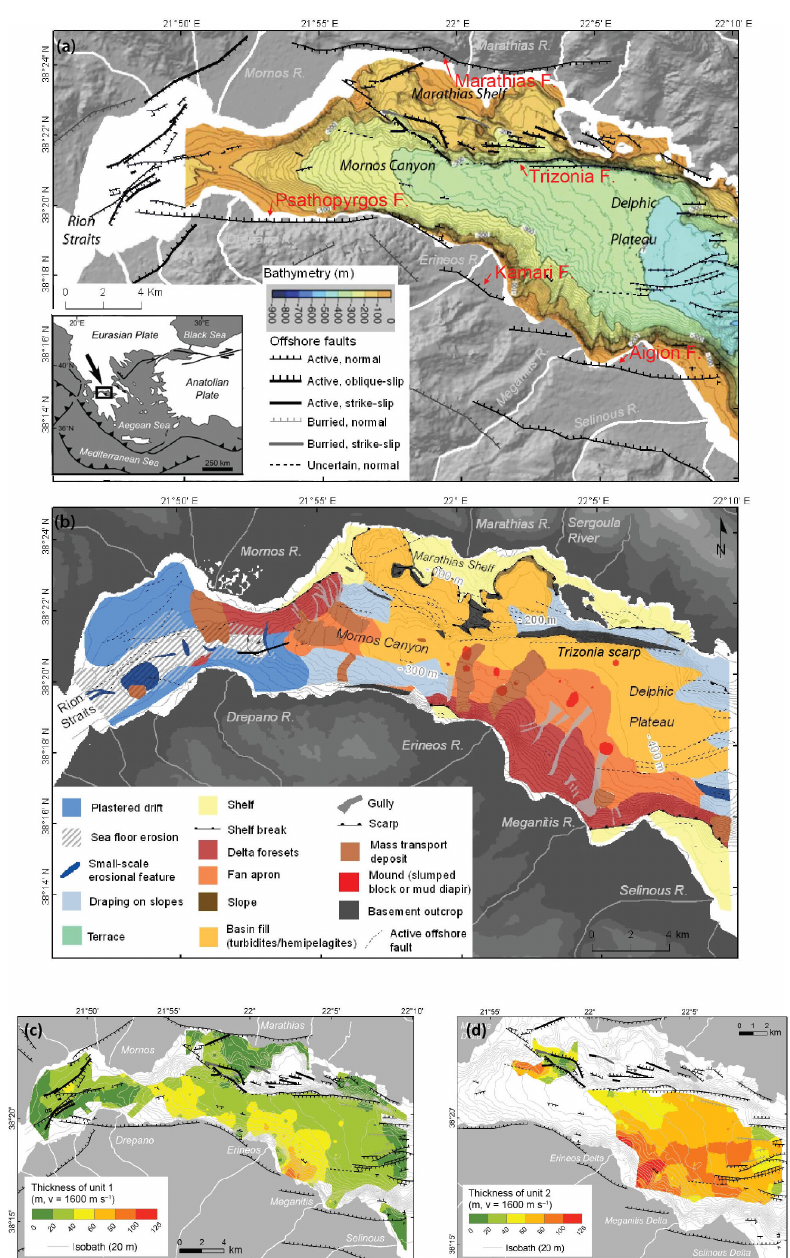
Figure 1. Study area with (a) the fault map of Beckers et al. (2015) with the bathymetry from Nomikou et al. (2011), (b) the morphosedi- mentary map of Holocene deposits of Beckers et al. (2016), the isopach maps of the Holocene ( c ; Beckers et al., 2016), and the preceding period from 10 to 130ka ( d ; Beckers, 2015). White areas in panels (c) and (d) correspond to the ones with poor data or with an absence of stratigraphic marker. Grey curves in middle and bottom figures are sea floor contour lines interpolated from the seismic